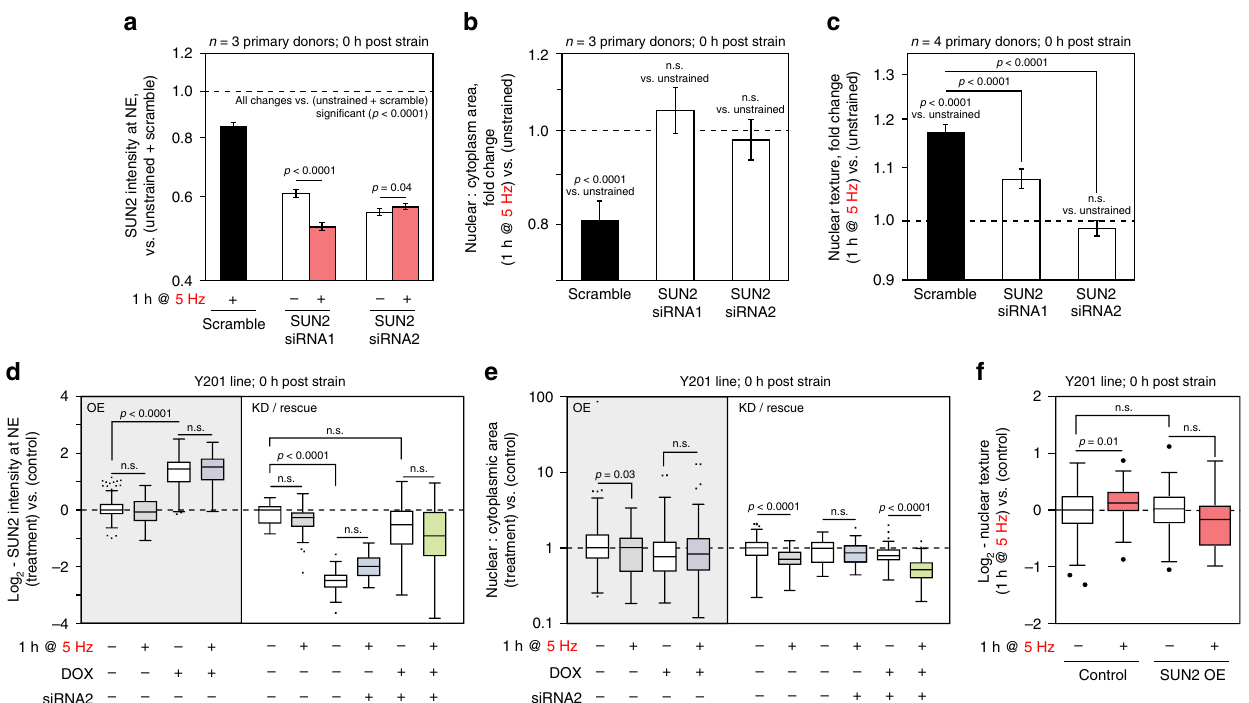
Fig. 8 Responses to CTS are blocked by KD or OE of SUN2. a SUN2 levels quanti fi ed by IF at the NE in primary hMSCs, following SUN2 KD (comparing two siRNA sequences) and in combination with CTS (1 h, 2.6 – 6.2% strain at 5 Hz; n = 3 donors). Both siRNAs were effective against SUN2 ( p < 0.0001). SUN2 level in the less potent KD (siRNA1) was further decreased by CTS ( p < 0.0001); the more ef fi cient KD (siRNA2) showed a small increase ( p = 0.04). b Ratios of nuclear to cytoplasmic areas in primary hMSCs following SUN2 KD and CTS ( n = 3 donors). SUN2 KD blocked the CTS-induced decrease to ratio ( p < 0.0001 for scrambled vs. CTS). c Changes to nuclear texture in primary hMSCs following SUN2 KD and CTS ( n = 4 donors). SUN2 KD signi fi cantly reduced strain-induced changes in nuclear texture ( p < 0.0001 for SUN2 KD vs. scrambled and CTS). Plots show mean ± s.e.m.; p -values determined from linear modeling (ANOVA). See Supplementary Figs. 11a – f for data distributions and variation between donors. d Quanti fi cation of SUN2 at the NE in immortalised hMSCs with inducible SUN2 OE ( p < 0.0001), SUN2 KD (siRNA2) ( p < 0.0001) and induced rescue of SUN2 KD, immediately following 5 Hz CTS. e Ratios of nuclear to cytoplasmic areas in immortalised hMSCs with SUN2 OE, SUN2 KD (siRNA2) and SUN2 rescue, immediately following CTS. Ratios were signi fi cantly decreased in control cells following CTS ( p = 0.03 and p < 0.0001), but not after OE or KD of SUN2. Rescue of SUN2 levels restored the response ( p < 0.0001) (see Supplementary Figs. 11g – i). d and e were normalized to ( − / − / − ) controls; ≥ 35 cells analysed per condition. f Changes to nuclear texture in immortalised hMSCs following SUN2 OE and CTS ( p = 0.01 for CTS vs. unstrained), ≥ 17 cells analysed per condition. Box-whisker plot center lines show medians, bounds of box show quartiles, whiskers show data spread and outliers determined by the Tukey method; signi fi cance determined by Dunnett ’ s multiple comparison tests. See Supplementary Table 1 for sample sizes